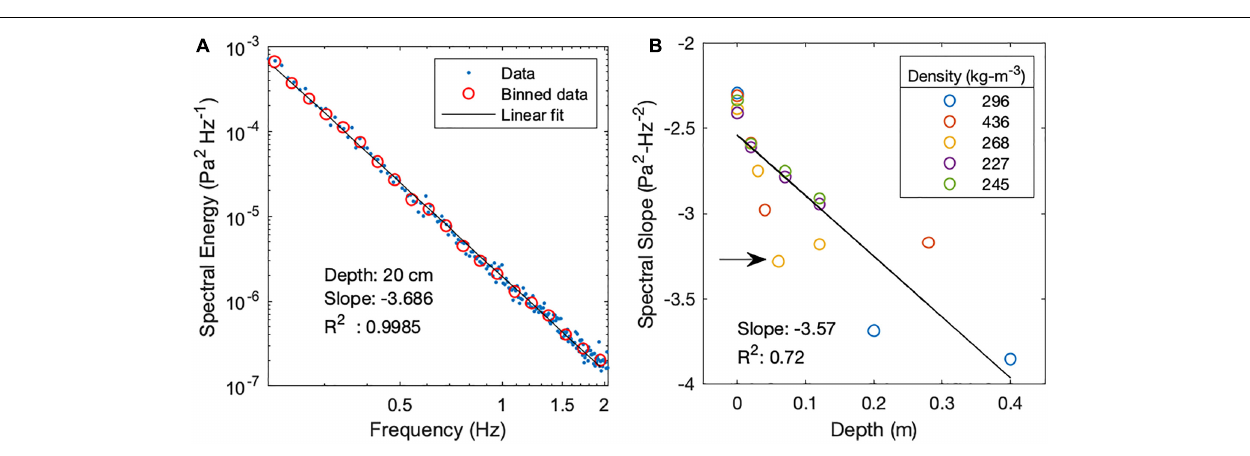
FIGURE 6 | Computation of spectral slope for the 20 cm depth pressure sensor for Case 1 (panel A ). The change in spectral slope with depth can be precisely computed only with cases for which spectral slope have R 2 values greater than 0.9. For each snow layer we compute the spectral slope relative to the sensor at the snow surface (panel B ). Results show a linear increase in the absolute value of spectral slope with depth. The average spectral slope is –2.54 to –3.57 d for depth ( d ) in the snow. The arrow in panel (B) points to an anomalous data point that has a larger absolute magnitude of slope than the data point below